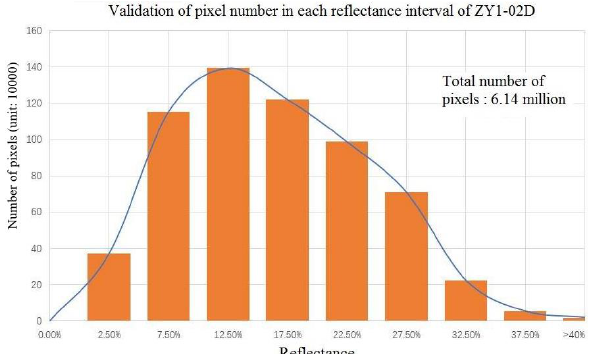
Figure 5 . Validation of pixel number in each reflectance interval of